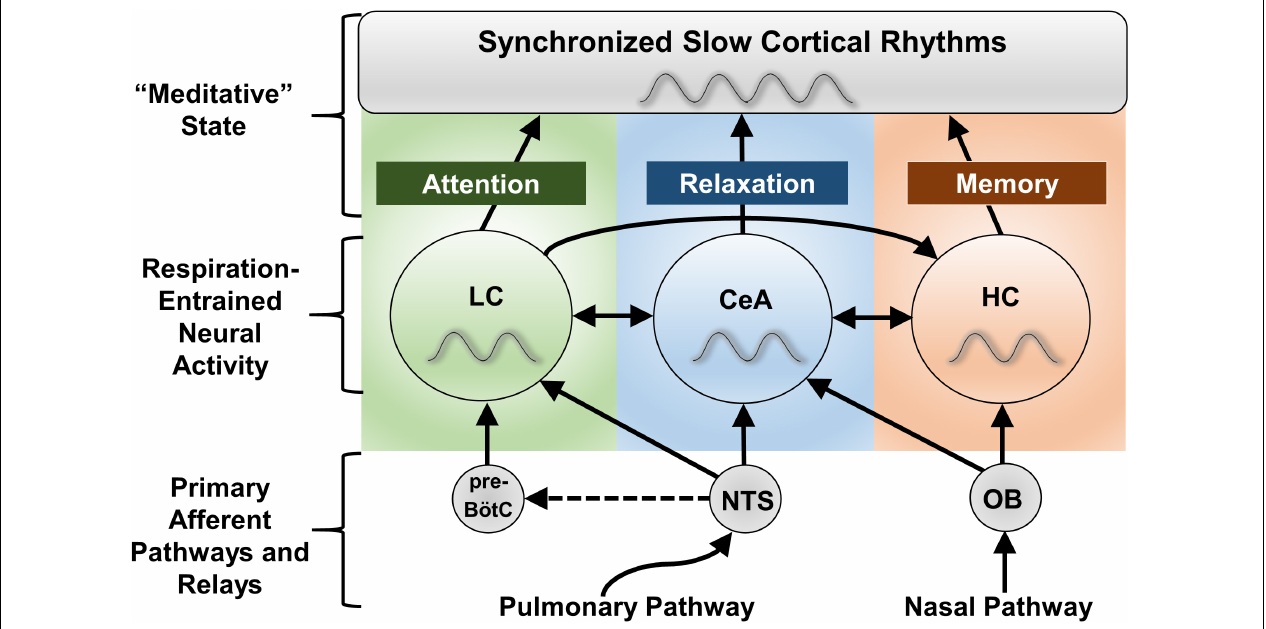
FIGURE 3 | Proposed CNS regions mediating the effects of slow breathing on anxiety, attention, and memory. The locus coeruleus (LC), central nucleus of the amygdala (CeA), and hippocampus (HC) all experience fluctuations in neuronal firing entrained to the respiratory cycle (Zhang et al., 1986a; Chen et al., 1991; Guyenet et al., 1993; Oyamada et al., 1998; Zelano et al., 2016). Despite impacting a broad array of functions, these regions are known to specialize in the regulation of anxiety state (CeA), attention and arousal (LC), and memory (HC), and together project to nearly the entire forebrain. In the forebrain, local processes converge into global respiratory rhythmic slow waves that may serve as the substratum for altered states of consciousness, including those subjectively experienced during meditation techniques involving slow, deep breathing. Interactions between LC, CeA, and HC pathways are proposed to complexly define cognitive and behavioral state. NTS stimulation may also activate the paraventricular nucleus of the hypothalamus (PVN, not shown) through the CeA to regulate the release of cortisol (Ressler, 2010), although this may be an indirect effect (no significant change in hypothalamic activity was observed with stimulation of Hoxb1 noradrenergic neurons, Chen et al., 2018). Dashed lines indicate hypothetical connections. NTS, nucleus of the solitary tract; OB, olfactory bulb; pre-BötC, pre-Bötzinger